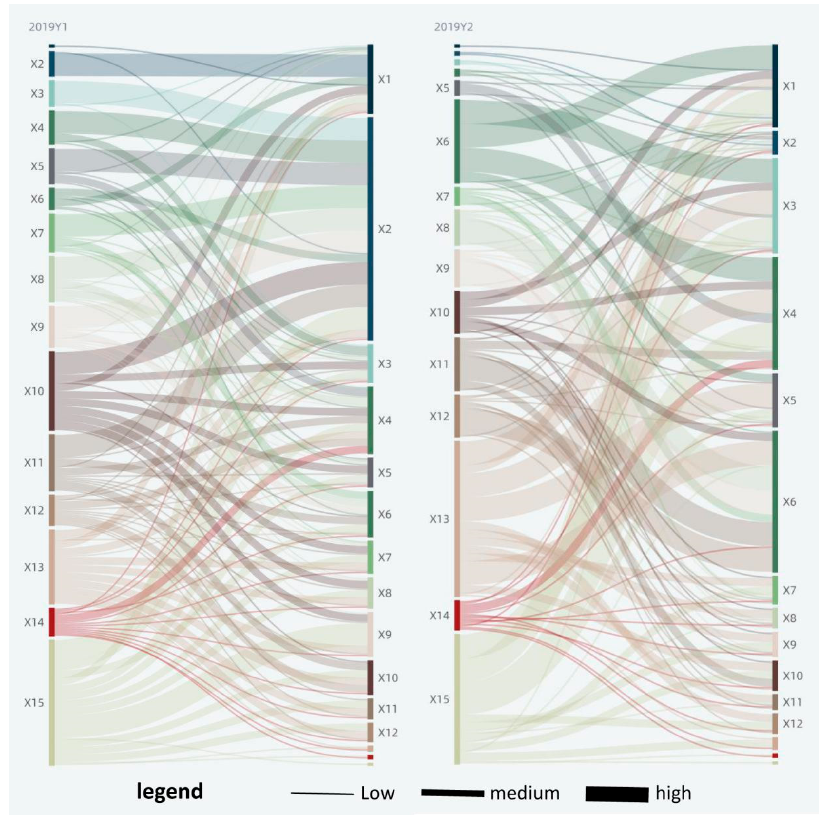
Figure 9. Analysis of interaction detector in 2019.